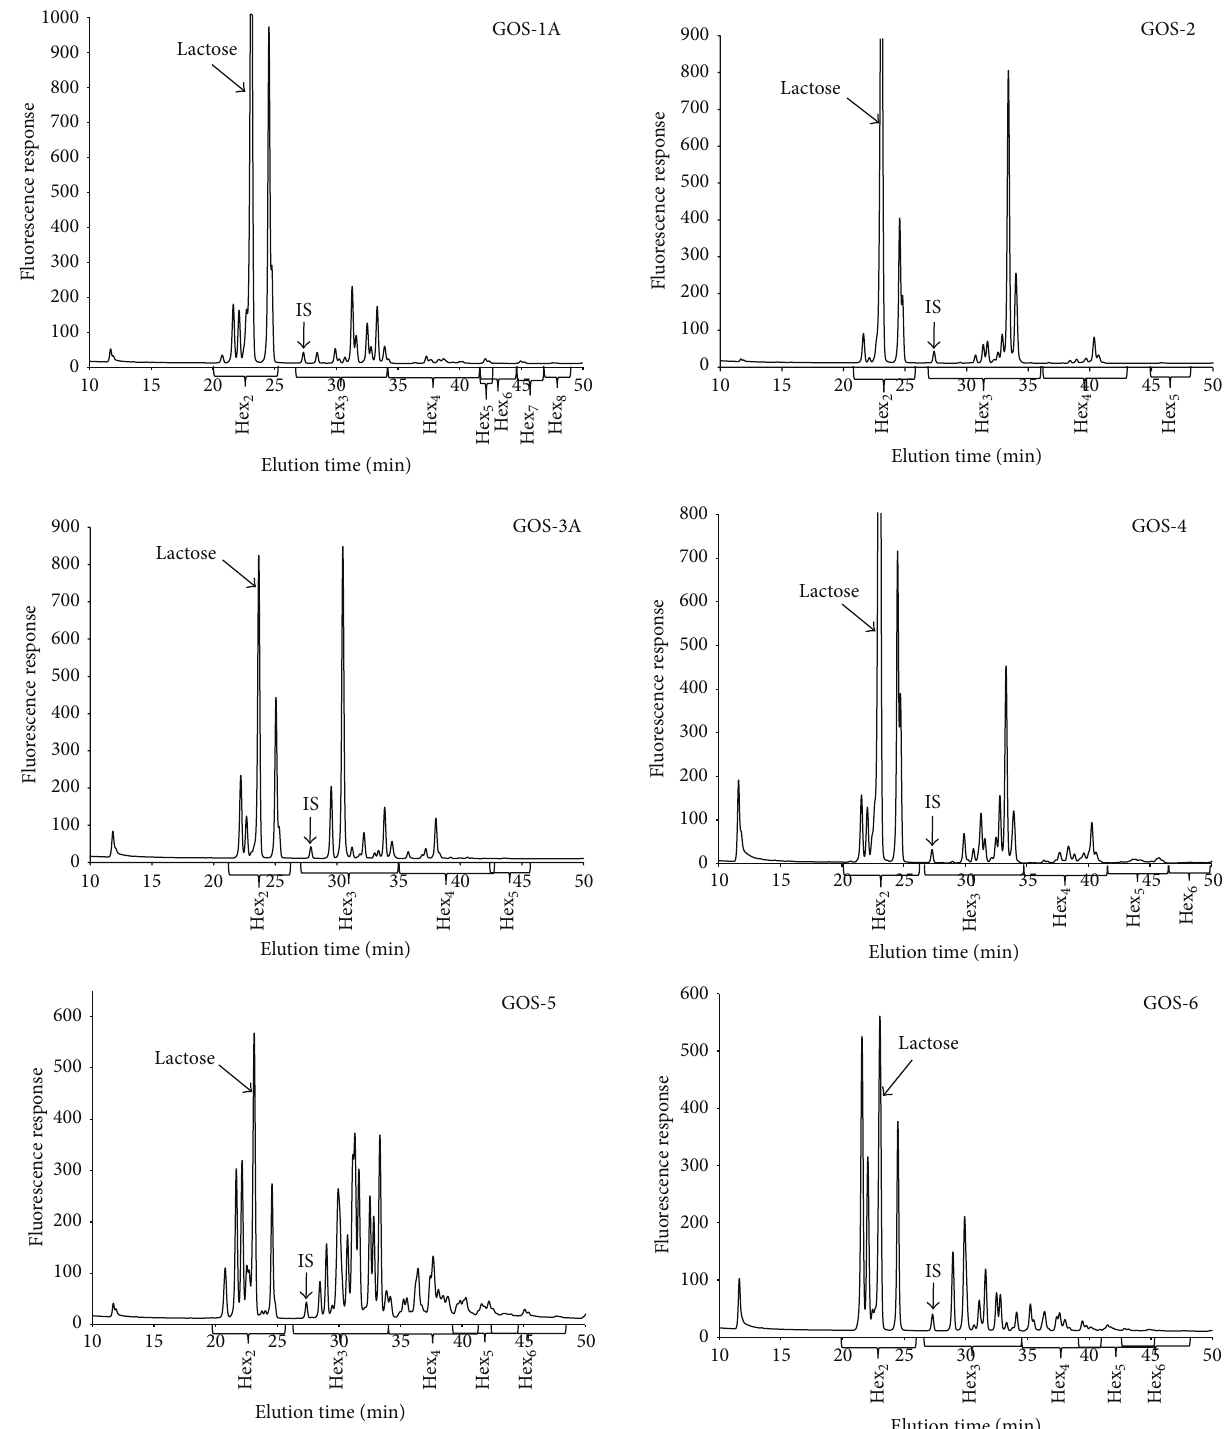
Figure 1: HPLC-FLD profiles of different GOS